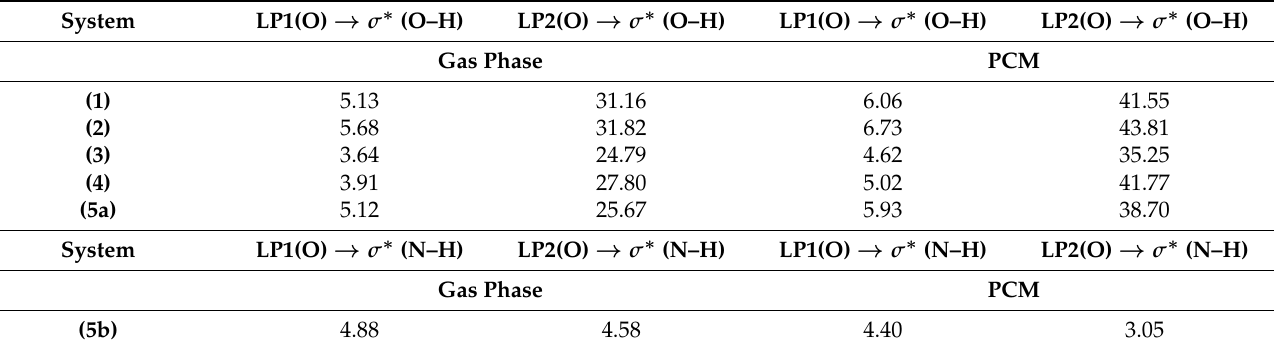
Table 4. Interaction energy (E2) between the lone pairs of the oxygen acceptor atom and the anti- bonding σ ∗ (O–H) orbital. The 5a and 5b labels indicate the presence of two intramolecular HBs in Compound 5 . All energies given in